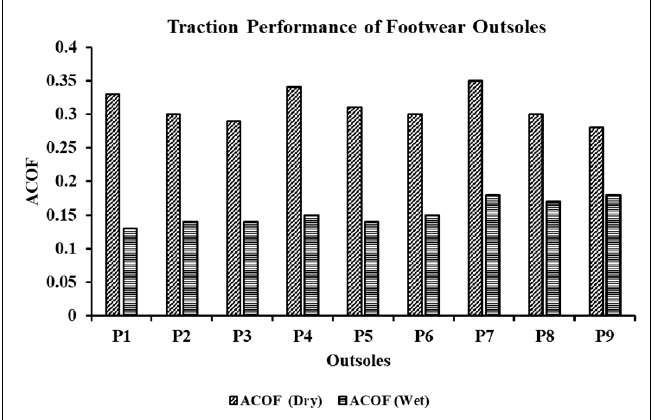
Figure 6. Traction performance of the outsoles tested using the mechanical slip tester.